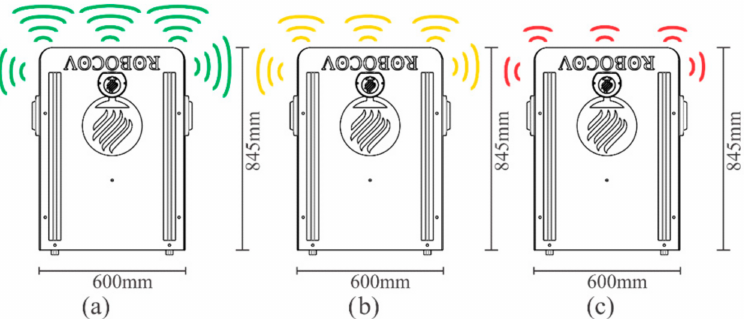
Figure 9. Proximity sensor placement and obstacle detection output: ( a ) no obstacle detected; ( b ) obstacle detected close; ( c ) obstacle detected nearby.